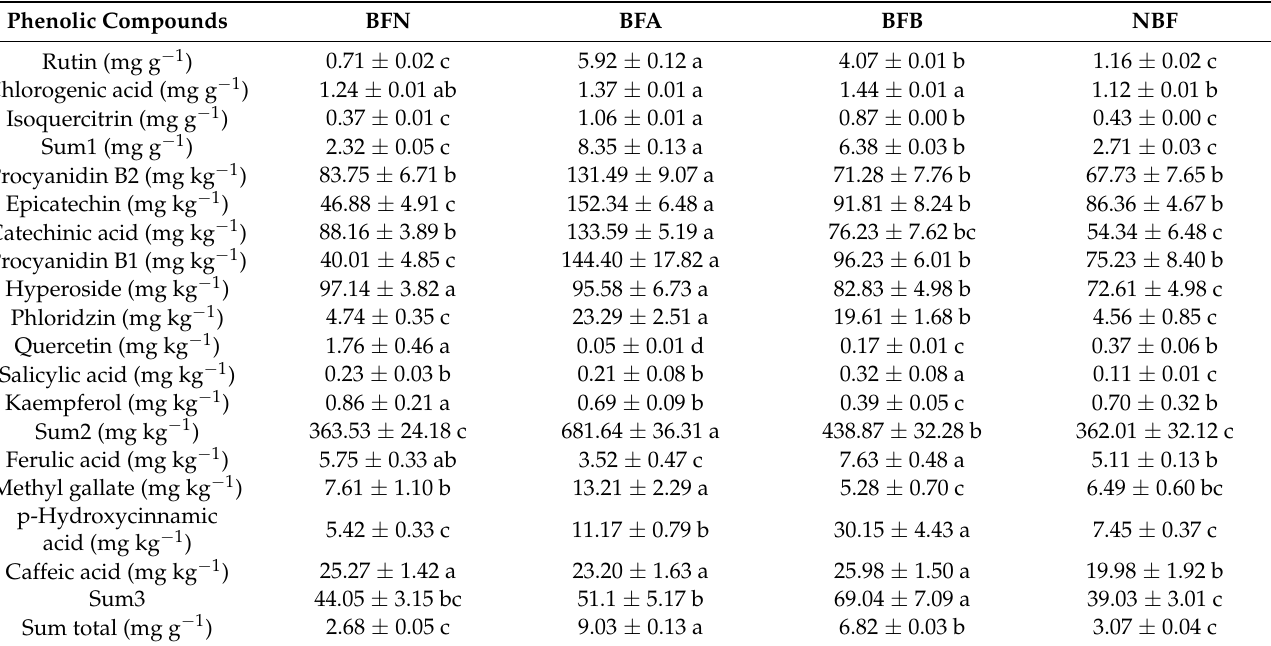
Table 1. Effects of sunburn on composition of phenolic compounds.